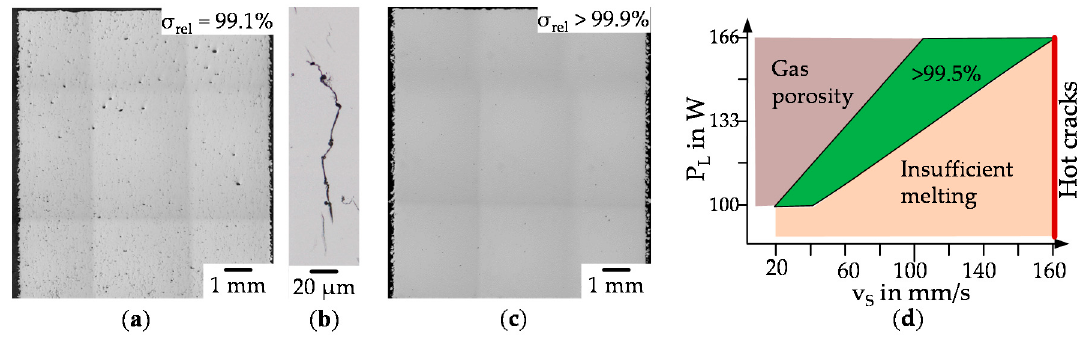
Figure 10. Cross-section (optical microcopy) of different specimens with the highest relative density of set 5 and 6 ( a ) P L = 400 W, vs = 6500 mm/s, Δ y = 20 µm, T pre = 200 °C ( b ) magnification of a hot crack in set 5 ( c ) P L = 133 W, vs = 80 mm/s, Δ y = 60 µm, T pre = 20 °C ( d ) process window for crack free manufacturing.